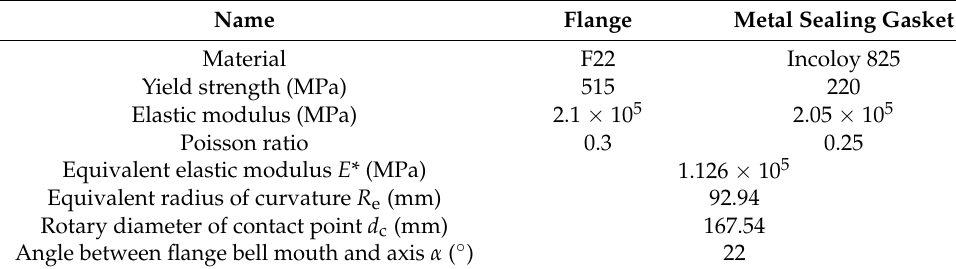
Table 1. Parameters of material and